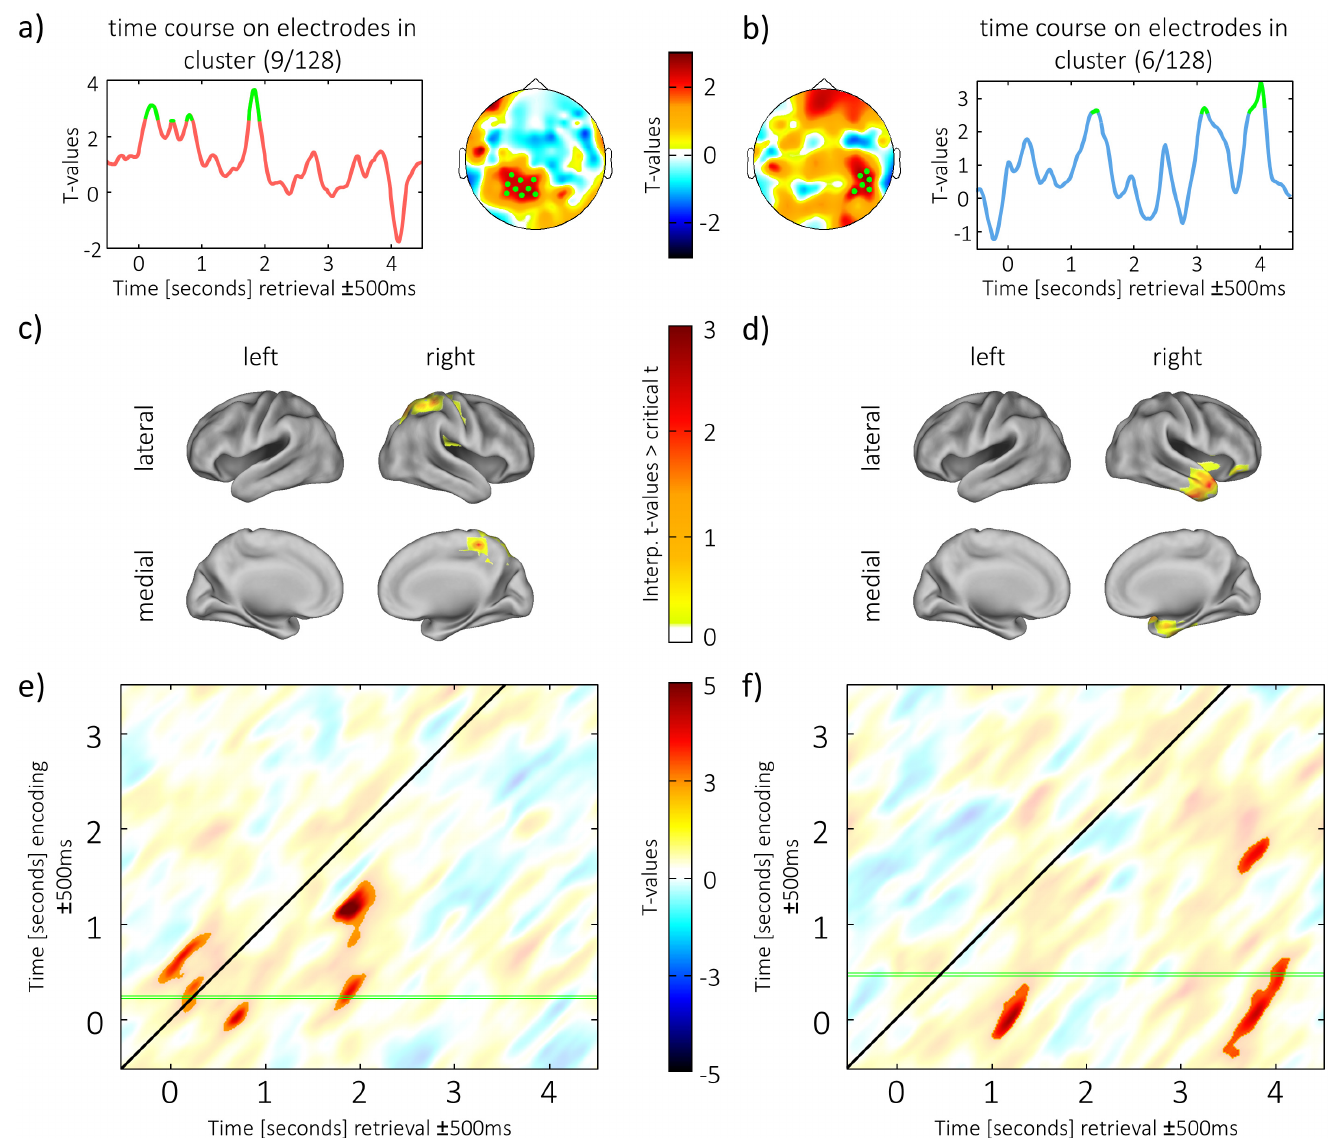
Fig 5. Encoding-retrieval similarity. (a) Topography of visual cluster and time course on electrodes in the cluster. (b) Topography of auditory cluster and time course on electrodes in the cluster. Electrodes in the cluster and time points that exceed threshold are highlighted in green. (c,d) Source reconstruction of encoding-retrieval similarity between 0 and 4 s of retrieval in the visual condition (c) and in the auditory condition (d). Statistical testing was run unrestricted on the whole brain level, and for each condition the maximal cluster (i.e., with the highest summed t -values) was plotted. (e,f) Encoding-retrieval similarity in the cluster (from a,b) between every time point of encoding and every time point of retrieval in the visual condition (e) and in the auditory condition (f). Clusters of significant differences are unmasked; remaining data is masked with transparency. The temporal imprecision of ± 500 ms is due to the width of the sliding window. The green lines in e and f highlight the original time window at encoding that is displayed in (a) and (b) (for